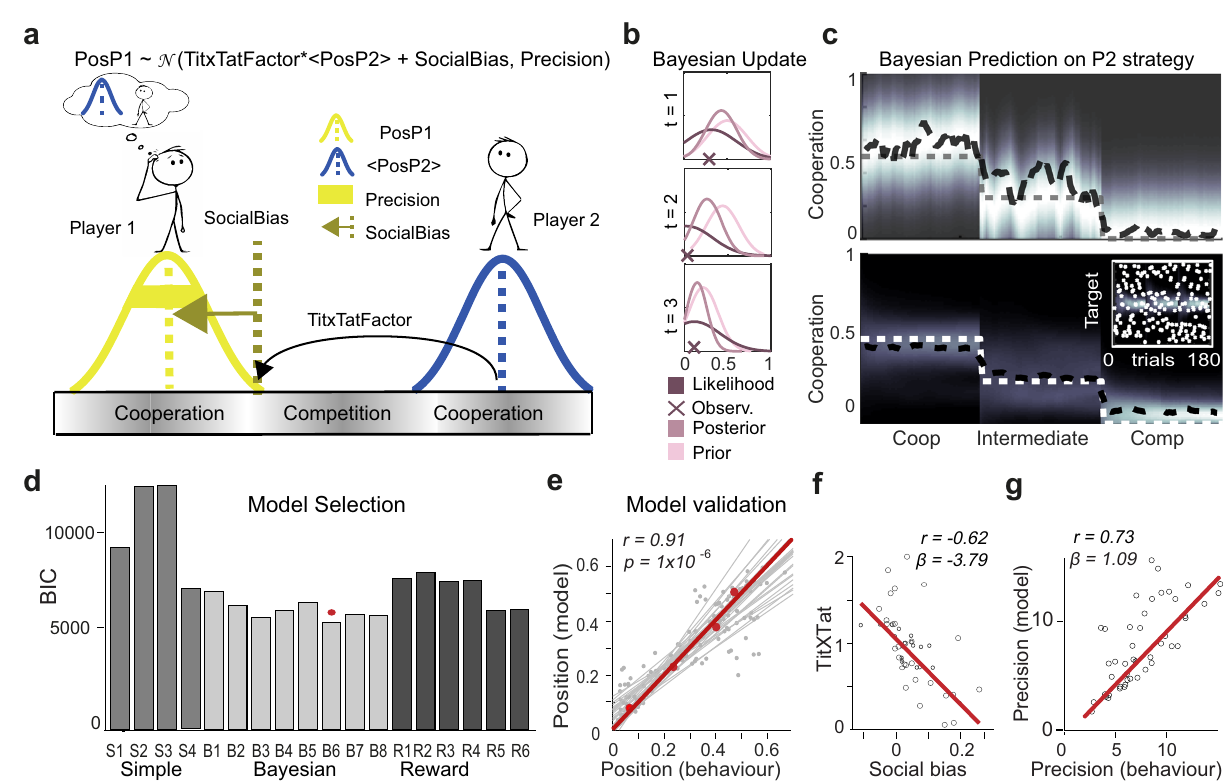
Fig. 3 | Modelpredictions. a Our best model described how player 1 ’ s (P1) choices resulted from (i) a tit-for-tat strategy whereby P1 reciprocated player 2 ’ s (P2) anticipated position ( “ Exp_PosP2 ” ) scaled by a context-dependant tit-for-tat factor (ii) P1 ’ s social preference or bias ( “ SocialBias ” ) and (iii) a precision parameter cap- strategy. c Top fi gure: Single participant representative example of P1 ’ s positions